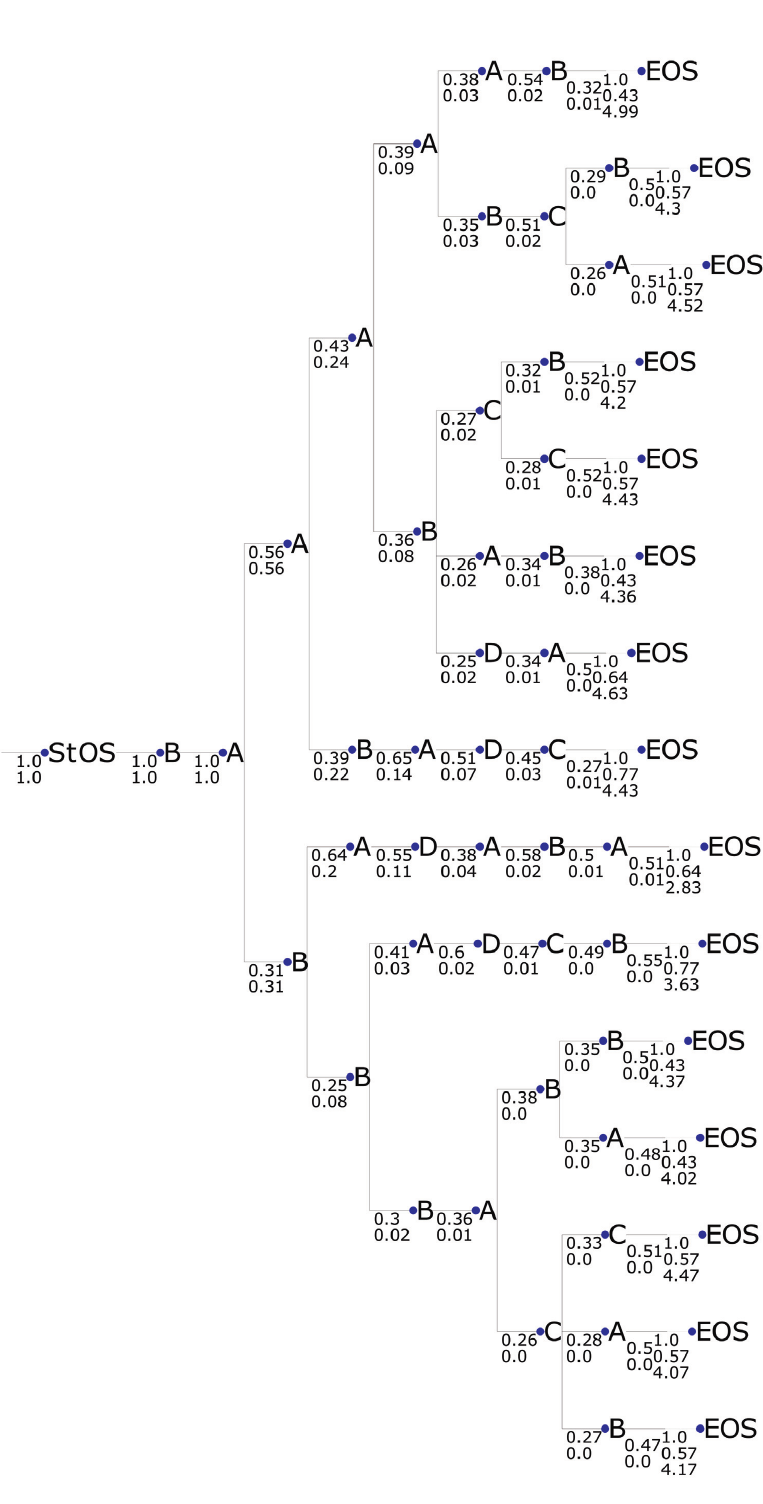
Figure 17: Output of the seq2probTree method for the tree-based system with input sequence [B